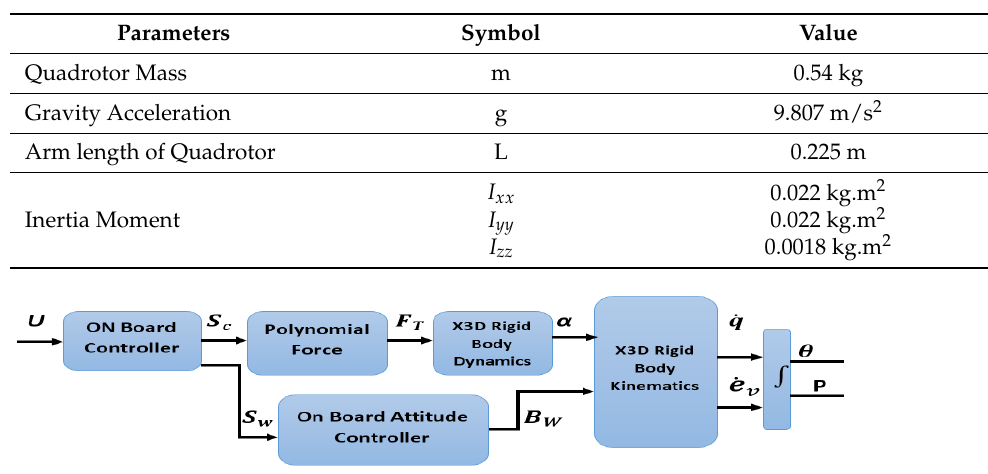
Figure 1. X3D Quadrotor re-evaluation model. Table 2. X3D Quadrotor parameter list.